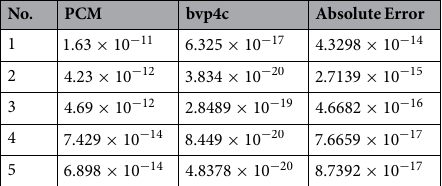
Table 6. PCM and bvp4c methods comparison for Ag : when φ Ag = 0.04, φ MgO = 0.02, Pr = 6.3, Re � = 0.13, Re ω =